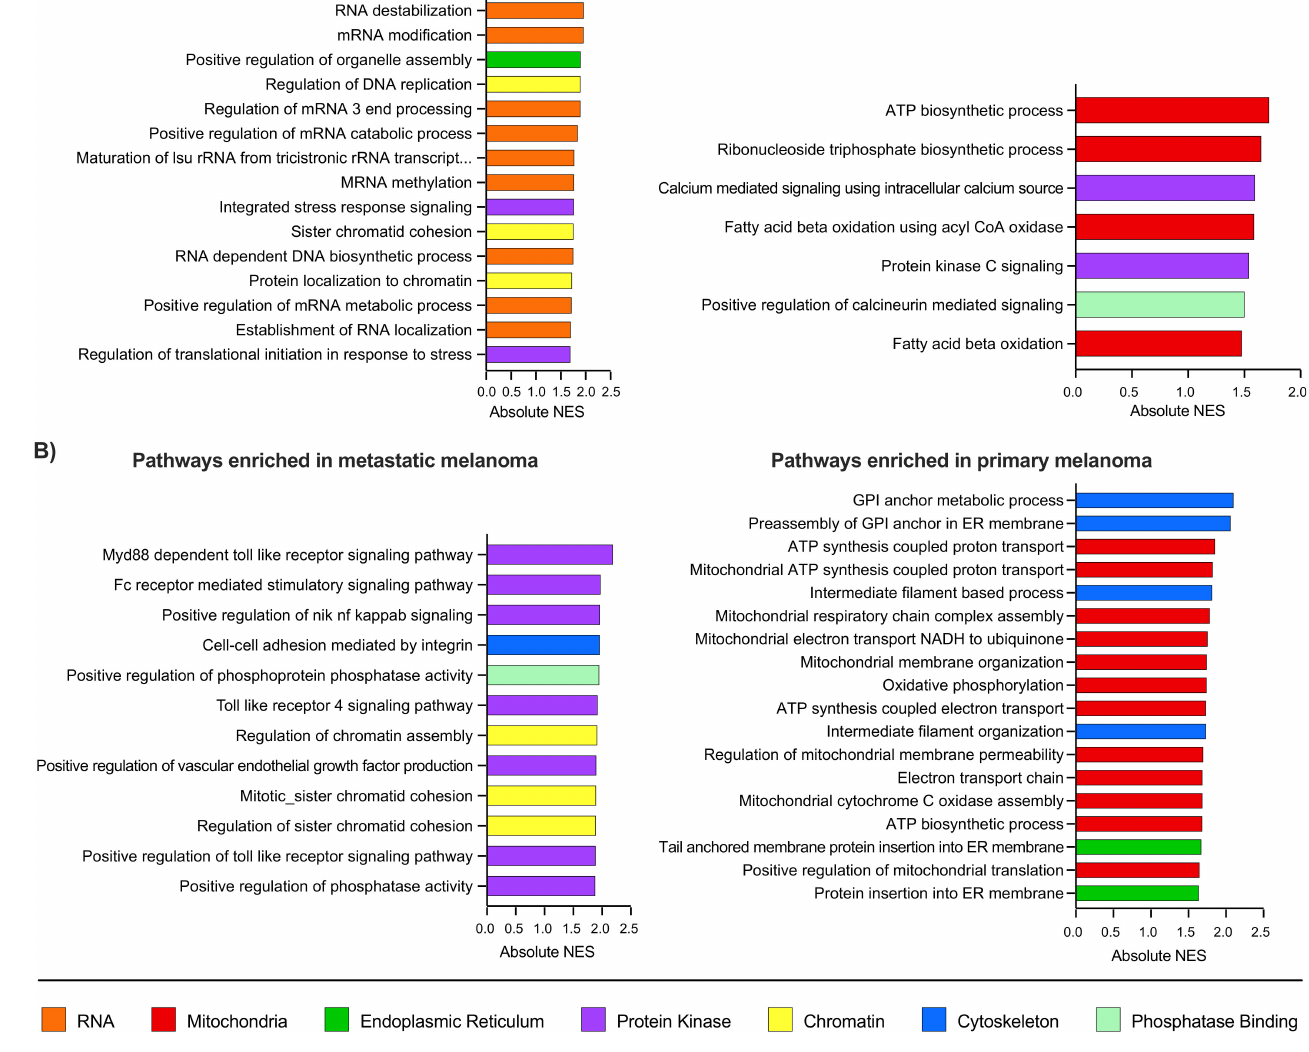
Figure 7. Transcriptionally dysregulated biological pathways associated with progression in melanoma. Gene set enrichment analysis (GSEA) using the GO: Biological Process gene set database showed significant enrichment of pathways associated with progression ( A , left) and non-progression (right) in primary tumors from TCGA. Enriched Pathways in Melanoma Metastases vs. Primary tumors from TCGA ( B ). GSEA using the GO:Biological Process gene set database showed significant enrichment of pathways associated with metastases (left) and primary tumors